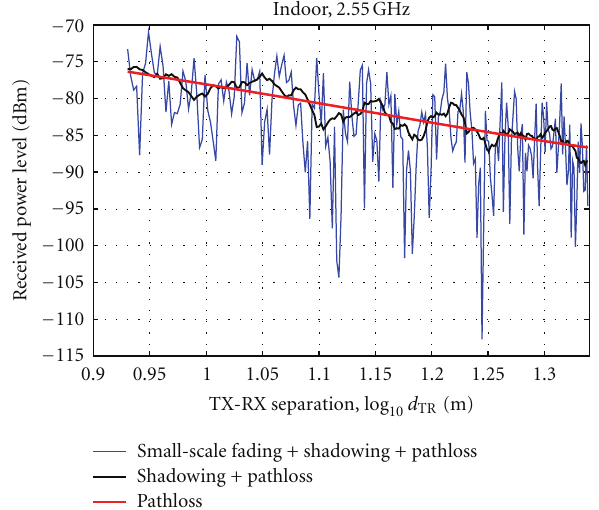
Figure 6: The received power in an indoor environment showing the e ff ect of small-scale fading, shadowing, and